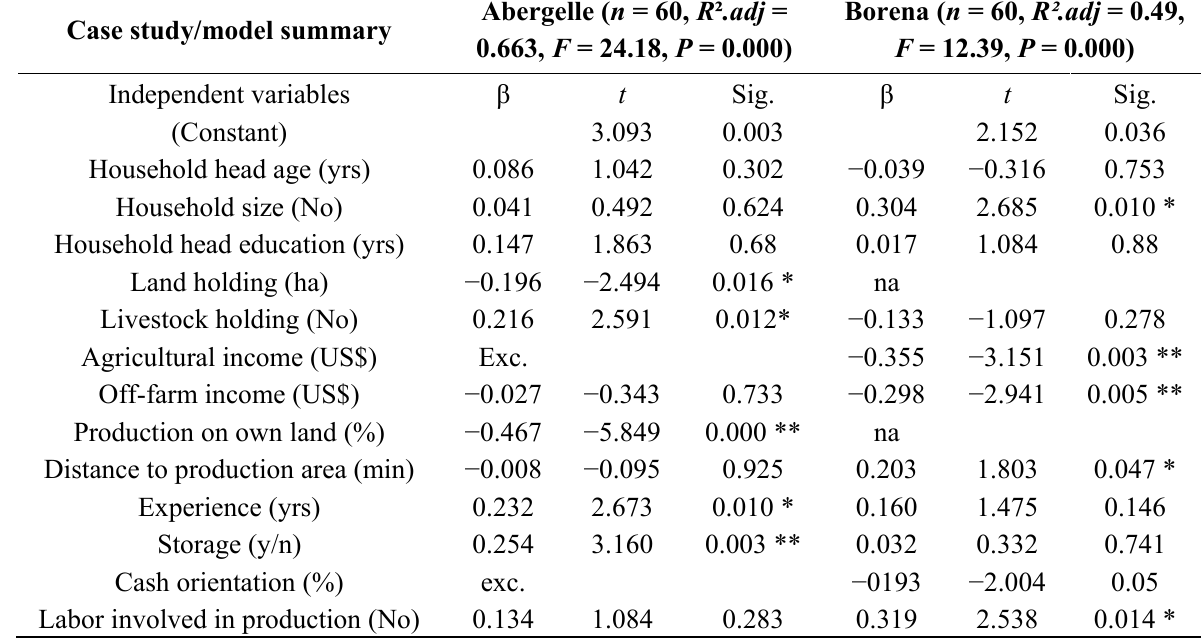
Table 7. Multiple regression analysis of gum and resin income against household socioeconomic characteristics and contextual variables, Abergelle and Borena. Abergelle ( n = 60, R ² .adj = Borena ( n = 60, R².adj = 0.49, Case study/model summary 0.663, F = 24.18, P = 0.000) F = 12.39, P =